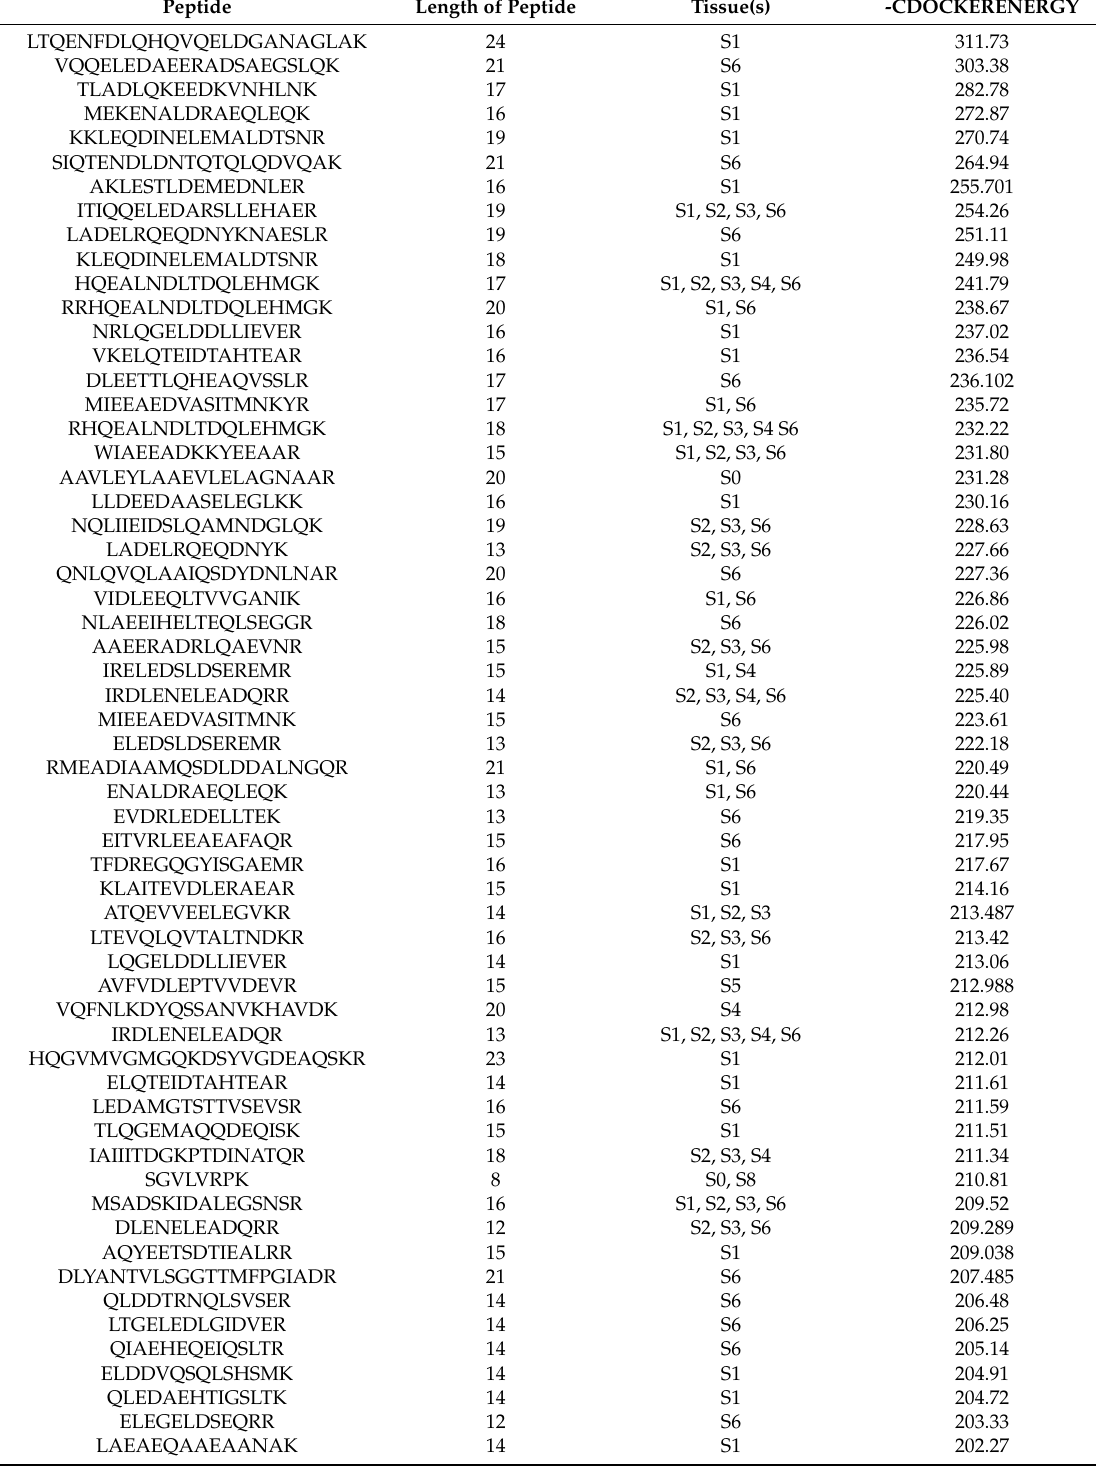
Table 2. Molecular docking of predicted antithrombotic